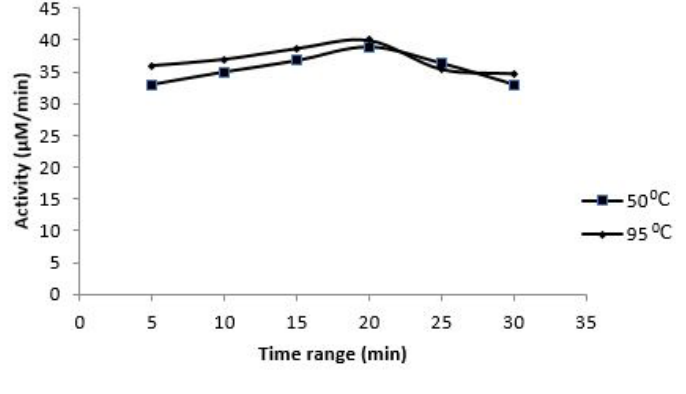
Figure 6: Effect of heat treatment on C. lanatus rind invertase activity. Effect of heat treatment on C. lanatus rind invertase activity